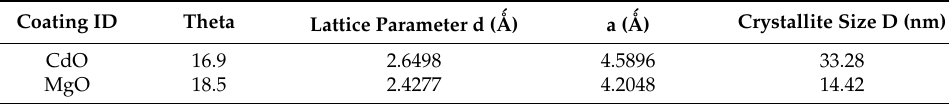
Table 1. Lattice parameters and crystallite size of CdO and